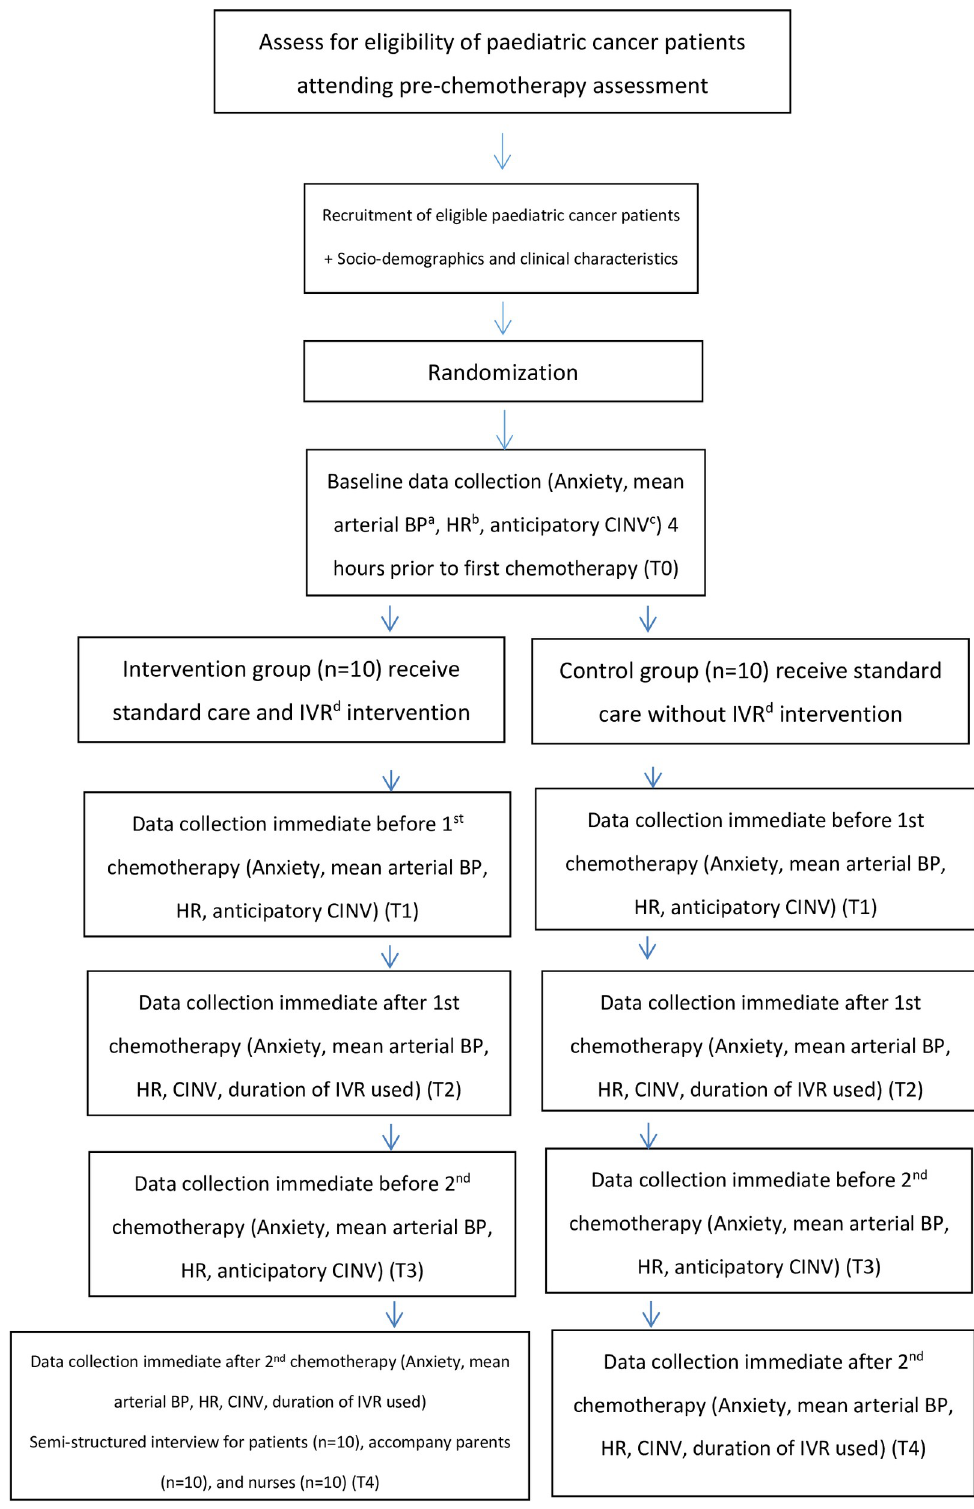
Fig 2. Flow diagram of trial design. a blood pressure; b heart rate; c chemotherapy-induced nausea and vomiting; d immersive virtual